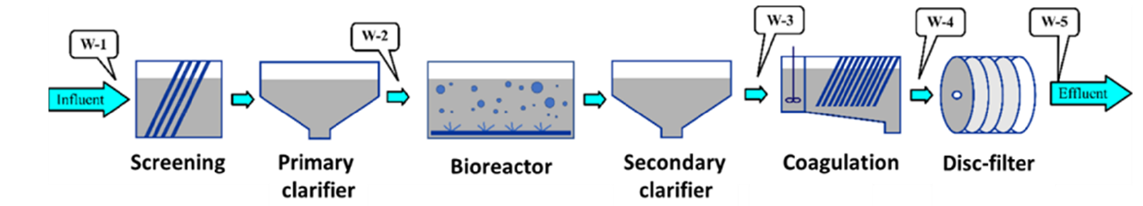
Figure 1. Sampling points and typical wastewater treatment process.